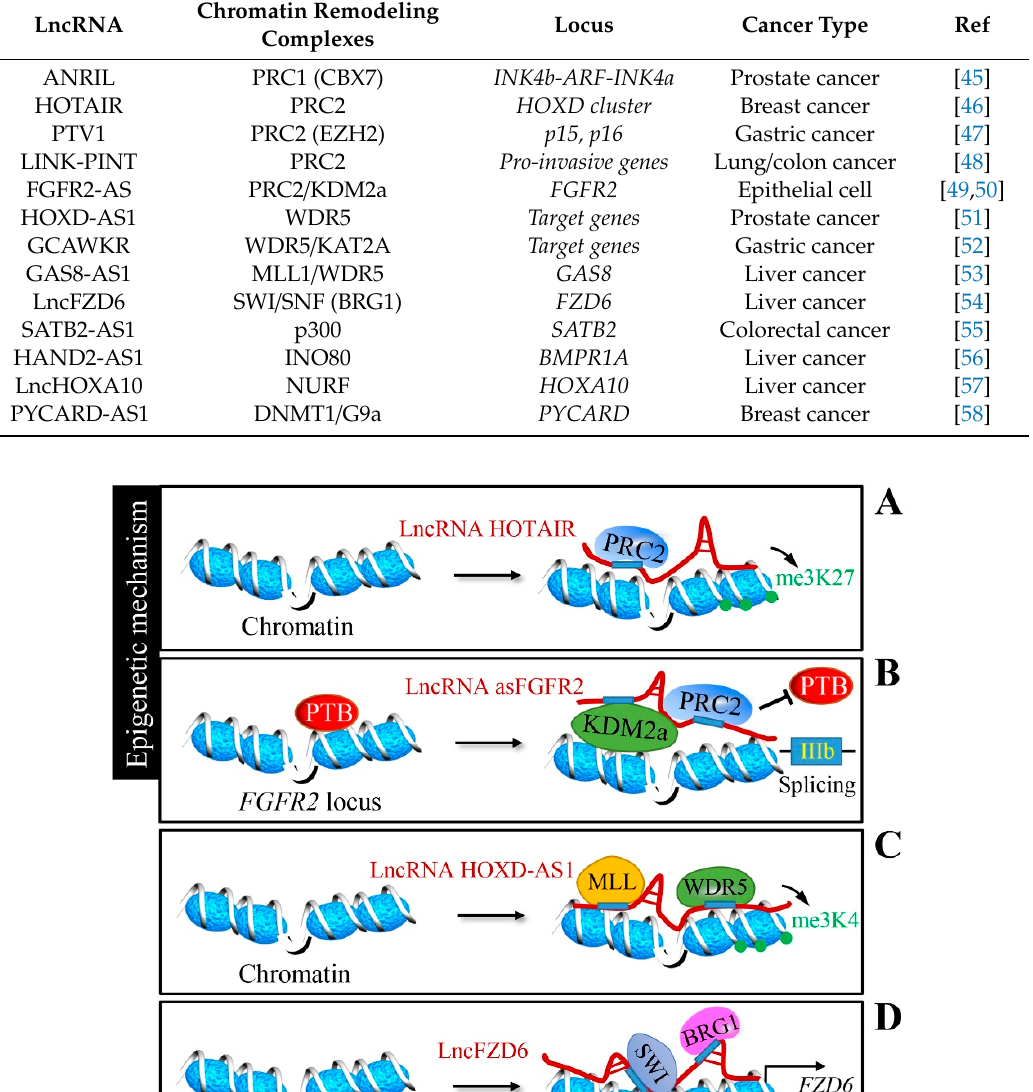
Table 2. Epigenetic regulation by lncRNAs.